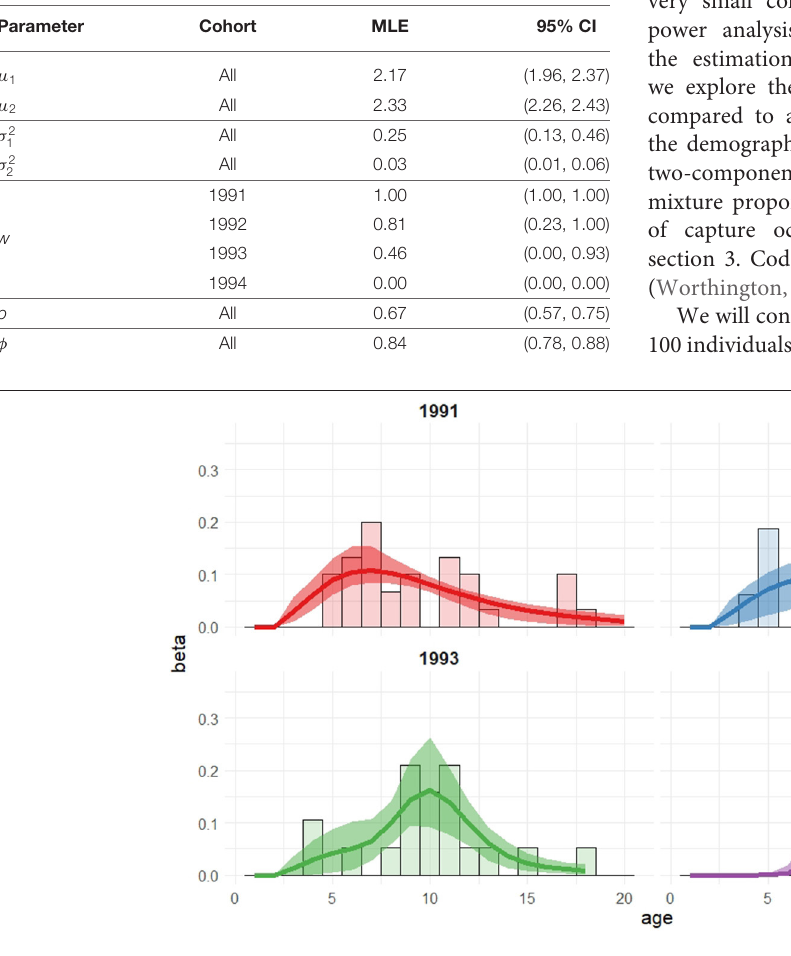
Frontiers in Ecology and Evolution |